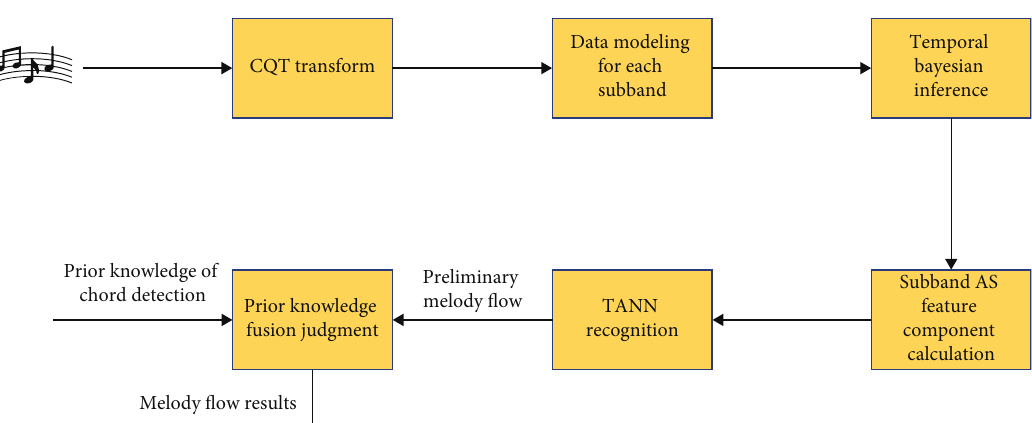
Figure 2: The algorithm fl ow of melody fl ow detection based on auditory saliency feature.